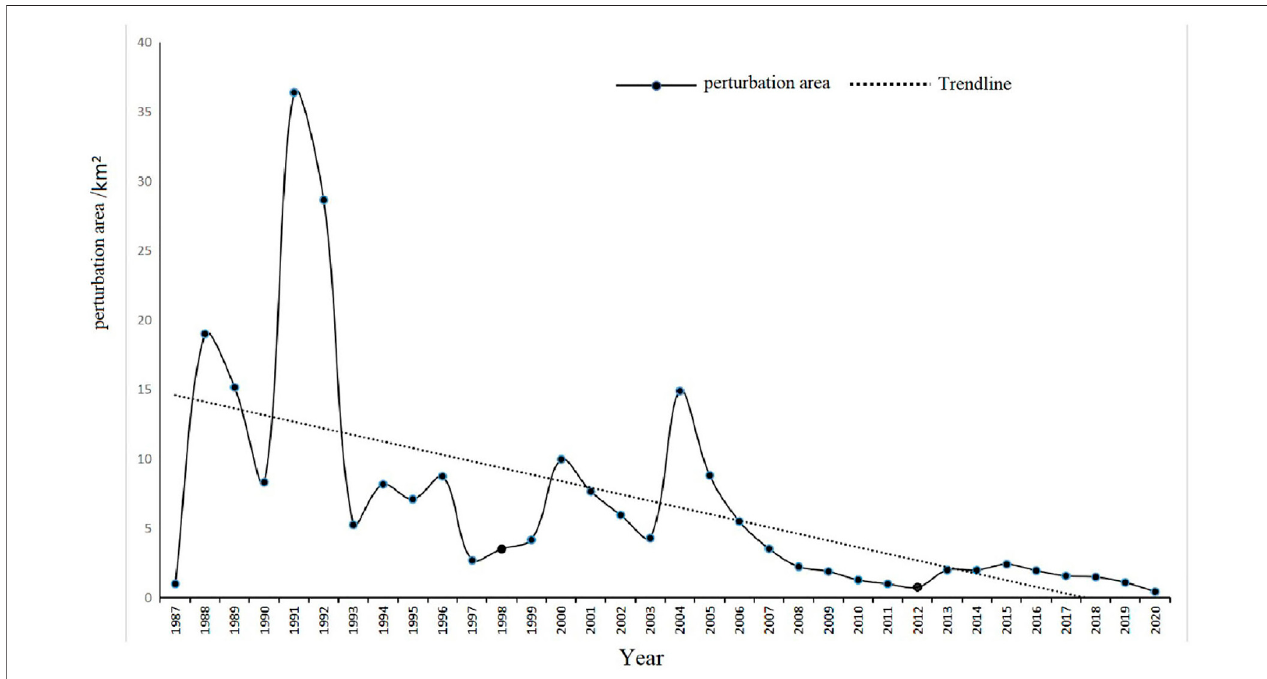
FIGURE 3 | Annual area map of forest disturbance in Hainan nature reserves from 1987 to 2020. Forest disturbance in Hainan reserves mainly occurred in the late 19th century and early 20th century from 1987 – 2020.